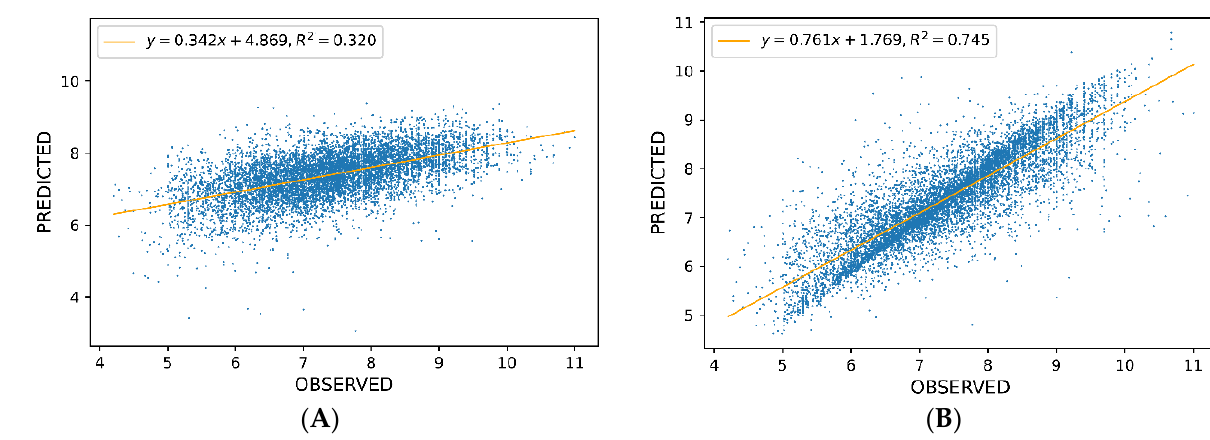
Figure 10. Predicted vs. observed values for ( A ) linear model and ( B ) AutoML model.